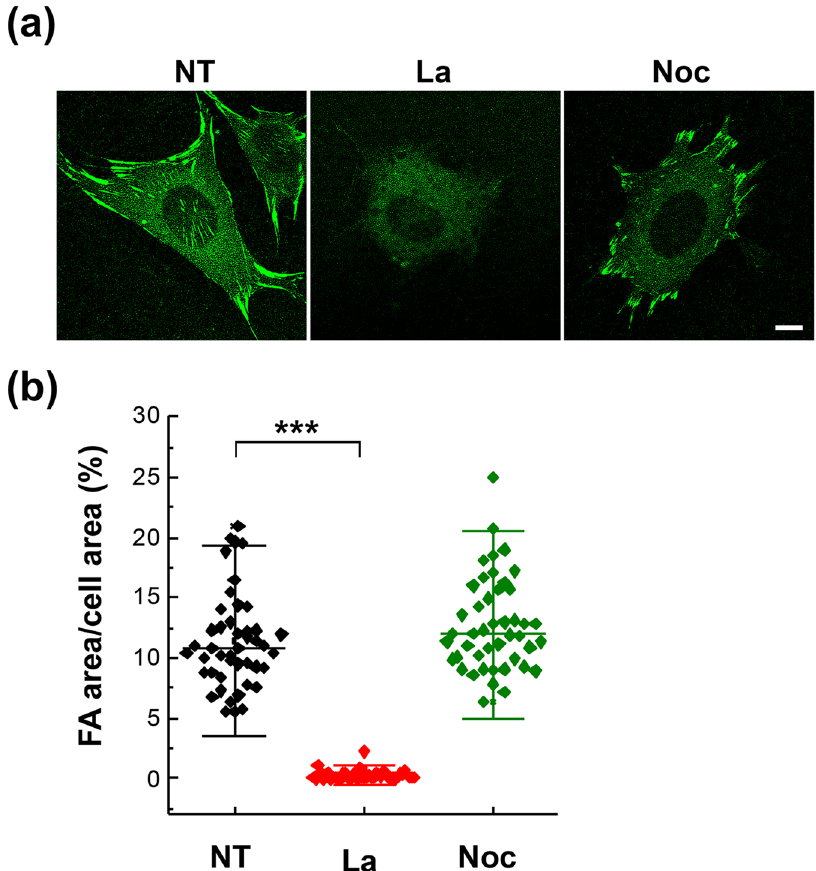
Figure 4. Actin polymerization is required for FA maturation. ( a ) MEFs were seeded on the 10 μ g/ml FN- coated polymer coverslip-bottom μ -dishes and treated with latrunculin (La; 1.0 μ M) or nocodazole (Noc; 10 μ M) for 30 min followed by immunostaining with anti-vinculin antibody for FA area determination. NT, no treatment. Scale bar, 10 μ m. ( b ) The variation of FA areas under various treatments. Data are expressed as the percentage of the total FA area of each cell relative to the cell area. Values represent mean ± standard deviation ( n = 45). *** P < 0.005 (Student’s